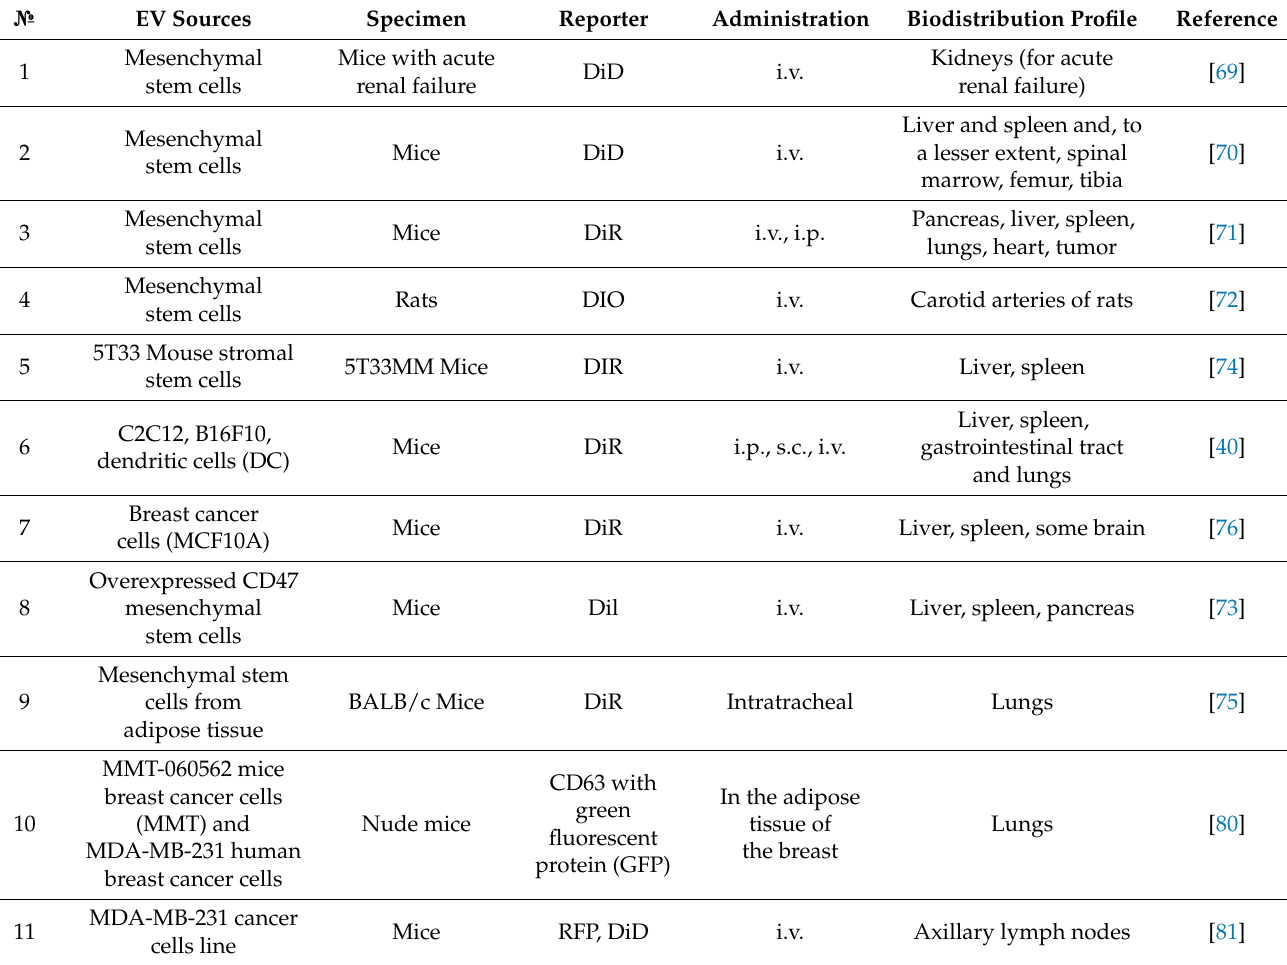
Table 2. Most commonly used lipophilic dyes and fluorescent